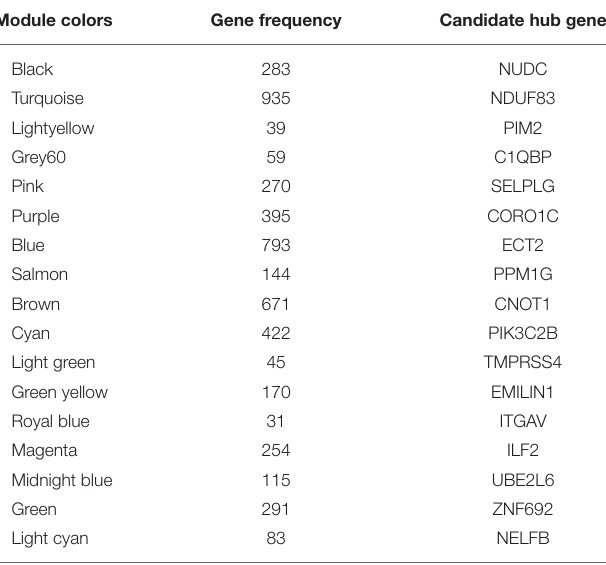
TABLE 1 | The candidate hub gene and gene numbers of all 17 modules determined by